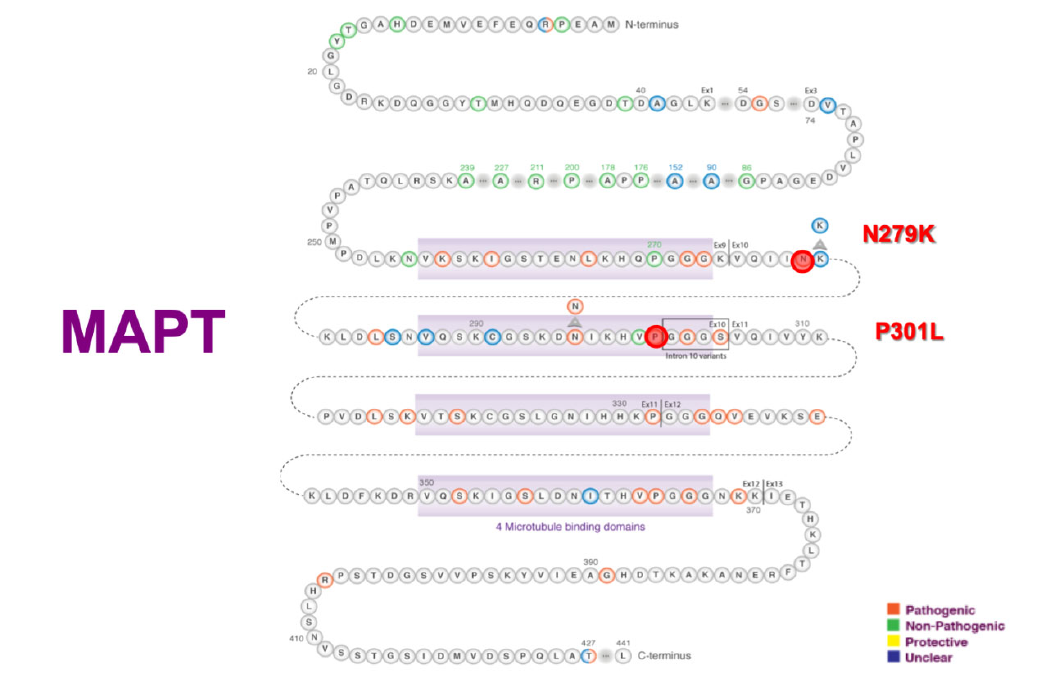
Figure 3. Latin American MAPT mutations.